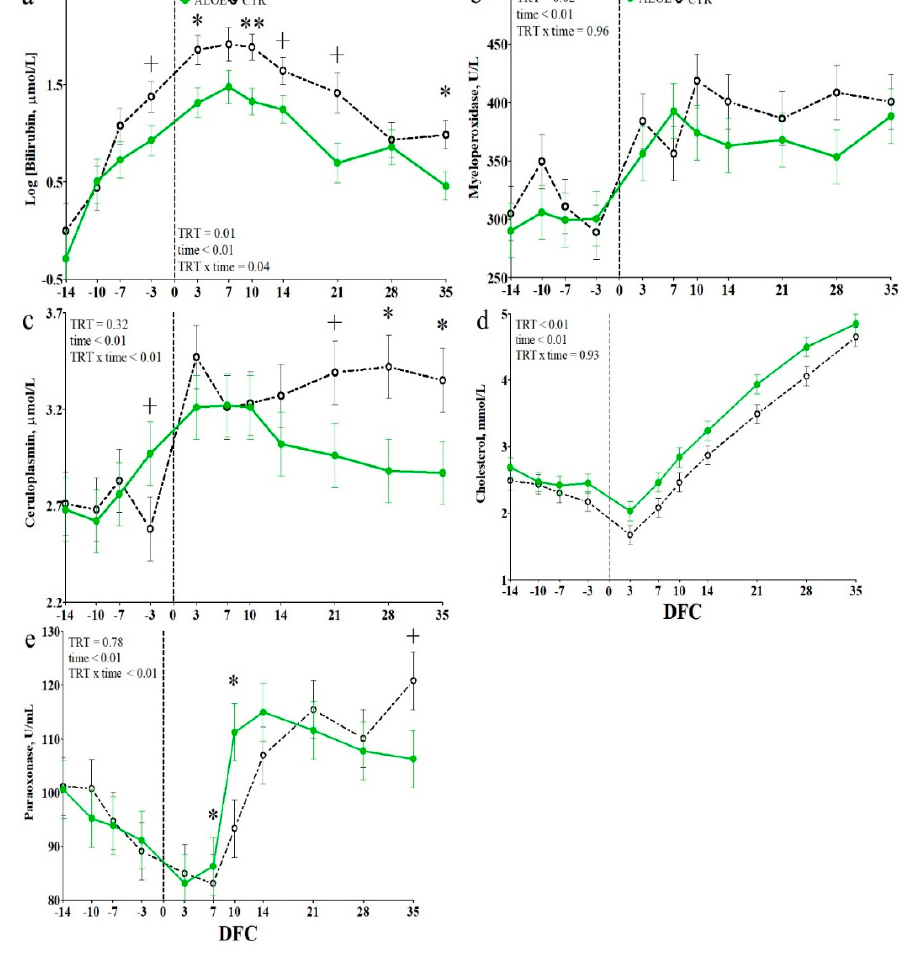
Figure 4. Time course of plasma concentrations of bilirubin ( a ), myeloperoxidase ( b ), ceruloplasmin ( c ), cholesterol ( d ) and paraoxonase ( e ) in dairy cows receiving placebo water (CTR; black dotted line) or cows receiving a drench of 200 g/d of Aloe arborescens Mill . whole plant homogenate between − 14 and 14 days from calving (AAM; green solid line). ** is p < 0.01; * is p < 0.05; + is p < 0.1; Log indicates data expressed as log-transformed; DFC is days from calving.